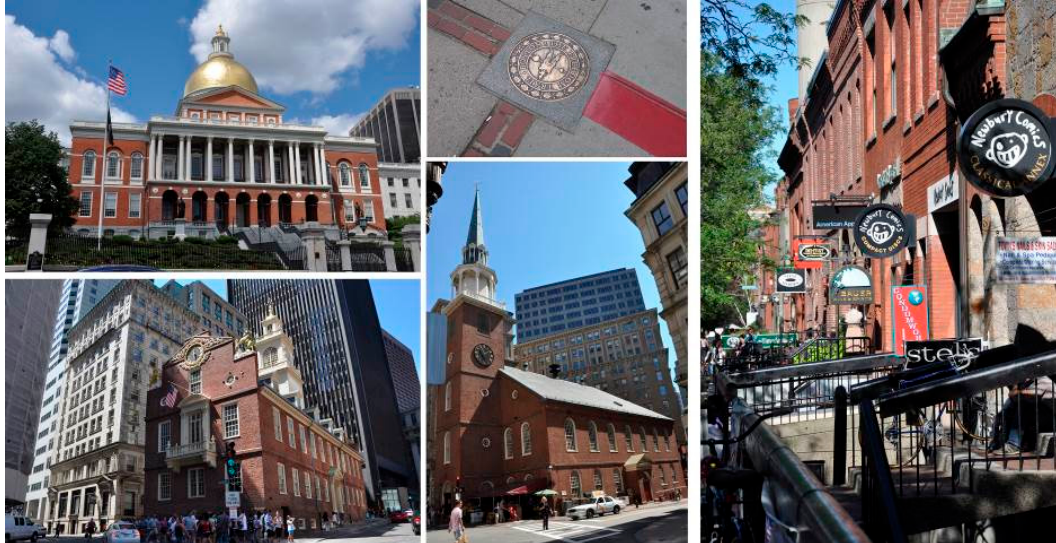
Figure 9. Some images of Boston’s Old Town: Left on the Freedom Trail; to the right a glimpse of the brownstones